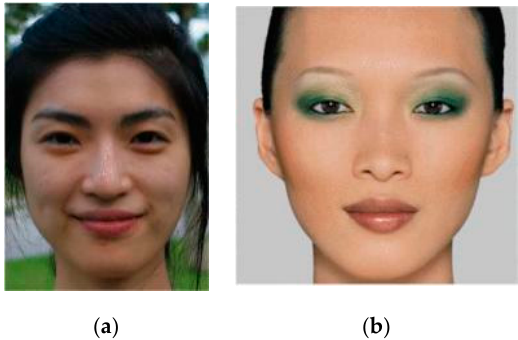
Figure 3. Face makeup by example. ( a ) A target image; ( b ) An example style image.